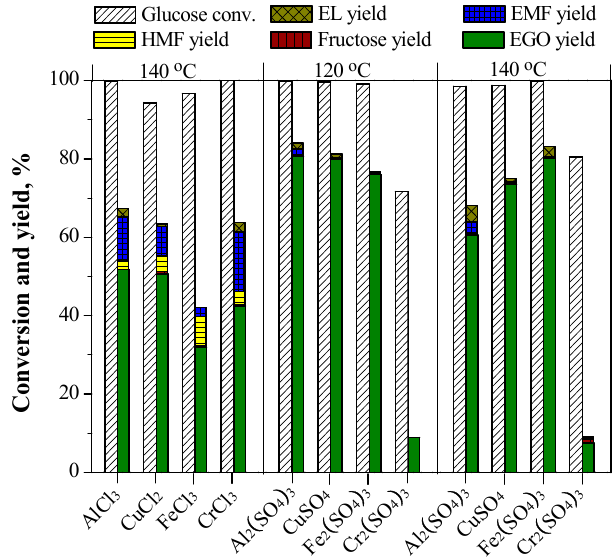
Figure 2. Conversion of glucose in ethanol medium with several specific metal salts. Reaction conditions: 0.2 mol/L glucose in ethanol; metal salt dosage of 0.02 mol/L; time of 10 h.